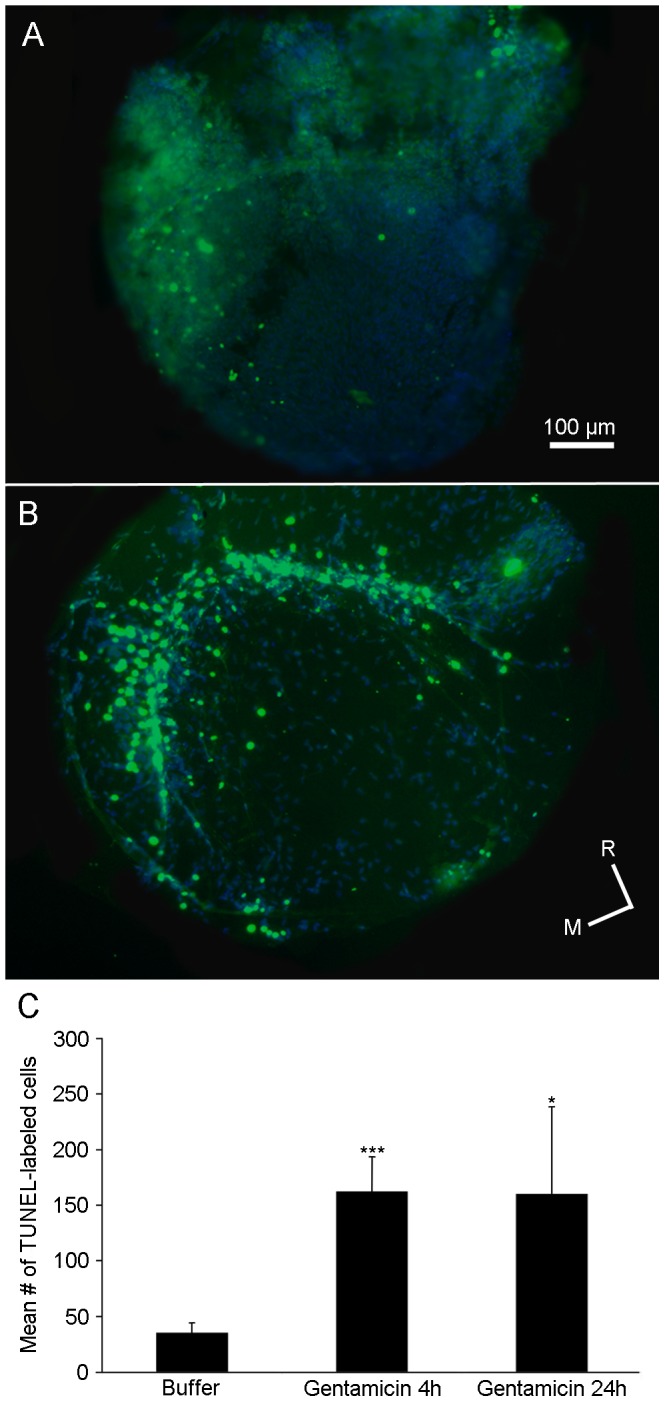
Gentamicin treatment increases the numbers of TUNEL-labeled cells in the adult utricle.Adult wildtype zebrafish received either a single intraperitoneal injection of (A) buffer or (B) 250 mg/kg gentamicin and allowed to recover for either 4 or 24 hours (4 hour data is shown). Fixed utricles were processed using a TUNEL-kit to label apoptotic cells (green cells) and co-labeled with DAPI (blue cells). (A–B) Low power (10X) images of the utricle reveals few TUNEL-labeled cells scattered throughout the utricle of a (A) buffer-treated animal but more cells with TUNEL-labeling in the (B) gentamicin-treated animal. (C) Mean number of TUNEL-labeled cells (± SD) in the utricles of buffer- or gentamicin-injected zebrafish. *p<0.05 or ***p<0.001; n = 9–12; M = medial, R = rostral.